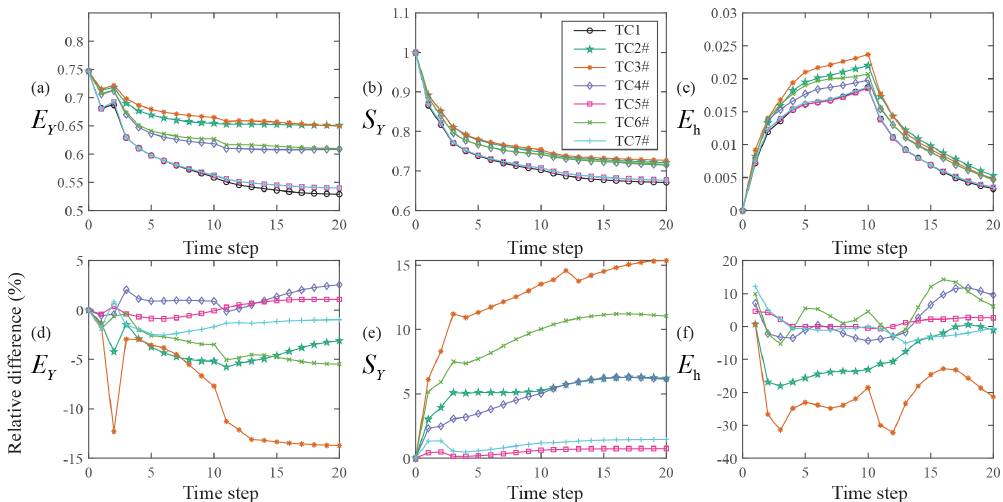
Figure 7. Temporal evolution of E Y (a) , S Y (b) , and E h (c) for TC1 and TC2#–TC7#. Temporal evolution of the relative difference between E Y (d) , S Y (e) , and E h (f) evaluated in TC2#–TC7# and their counterparts related to